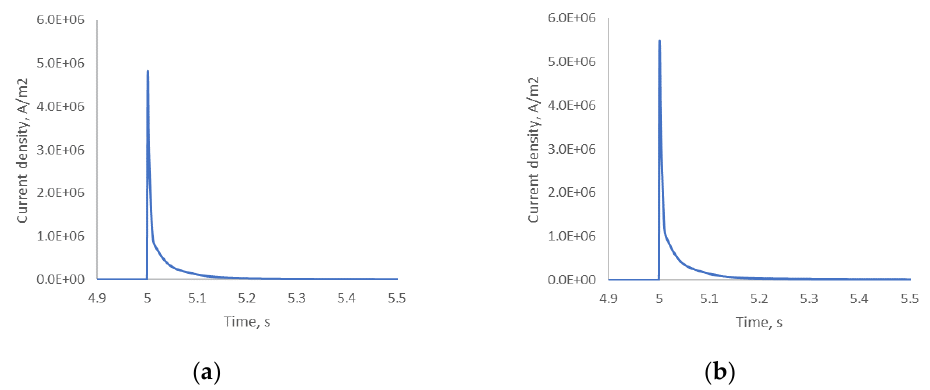
Figure 9. Calculated eddy currents on cylindrical surface of samples: (a) EN8, (b) AA2014-T6.